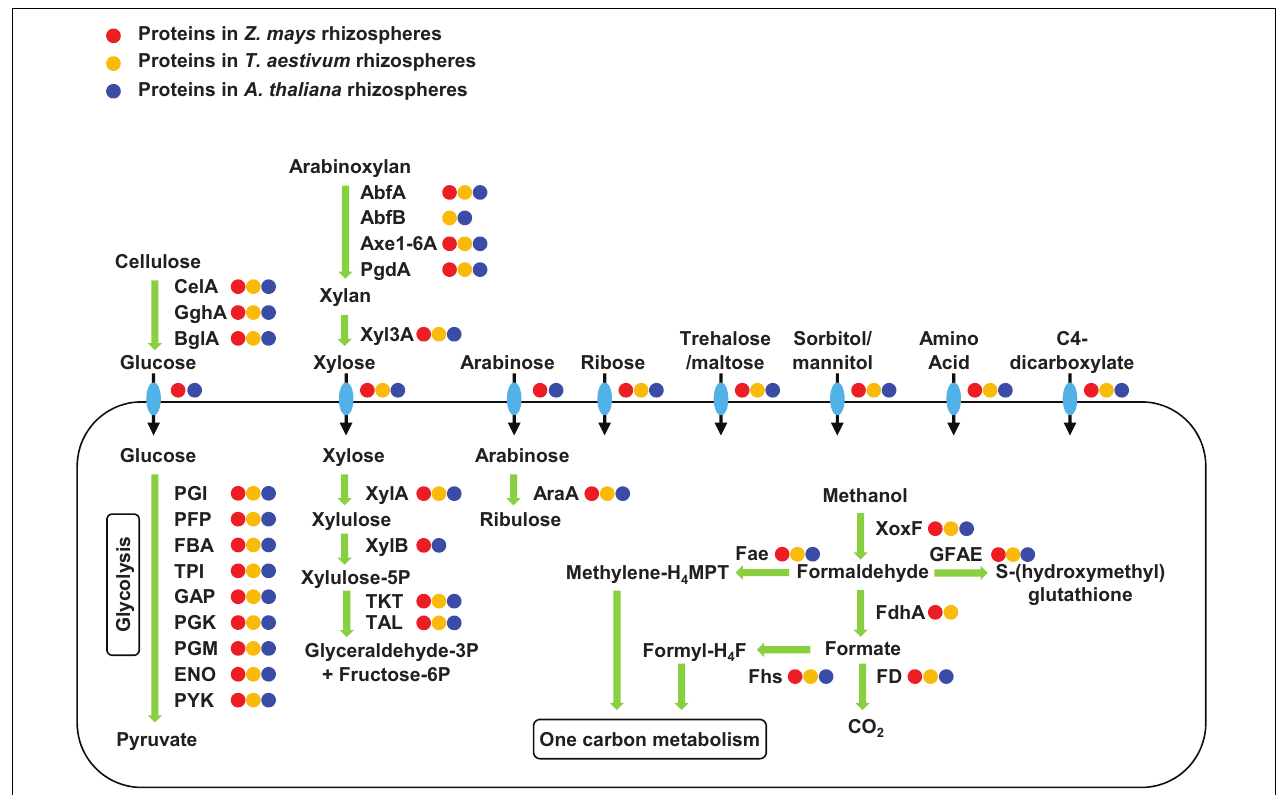
FIGURE 3 | Expressed proteins for carbon uptake and metabolism in the rhizosphere communities. Enzymes are labeled with circles in three different colors for their protein expression in the rhizospheres of the three different plants. The rhizosphere communities expressed proteins for the transportation and metabolism of many complex carbohydrates and methanol. CelA, endo-1,4-beta-D-glucanase; GghA, exo-1,4-beta-glucosidase; BgIA, beta-glucosidase; PGI, phosphoglucose isomerase; PFP, pyrophosphate-dependent fructose-6P 1-phosphotransferase; FBA, fructose-bisphosphate aldolase; TPI, triose-phosphate isomerase; GAP, glyceraldehyde-3P dehydrogenase; PGK, phosphoglycerate kinase; PGM, phosphoglycerate mutase; ENO, enolase; PYK, pyruvate kinase; AbfA, alpha-arabinosidase; AbfB, alpha-arabinosidase; Axe1-6A, feruloyl esterase; PgdA, acetylxylan esterase; Xyl3A, xylan 1,4-beta-xylosidase; XylA, xylose isomerase; XylB, xylulose kinase; TKT, transketolase; TAL, transaldolase; AraA, arabinose isomerase; XoxF, methanol dehydrogenase; FdhA, glutathione-independent formaldehyde dehydrogenase; FD, formate dehydrogenase; GFAE, glutathione-dependent formaldehyde-activating enzyme, Fae, 5,6,7,8-tetrahydromethanopterin hydro-lyase; Fhs, formate-tetrahydrofolate